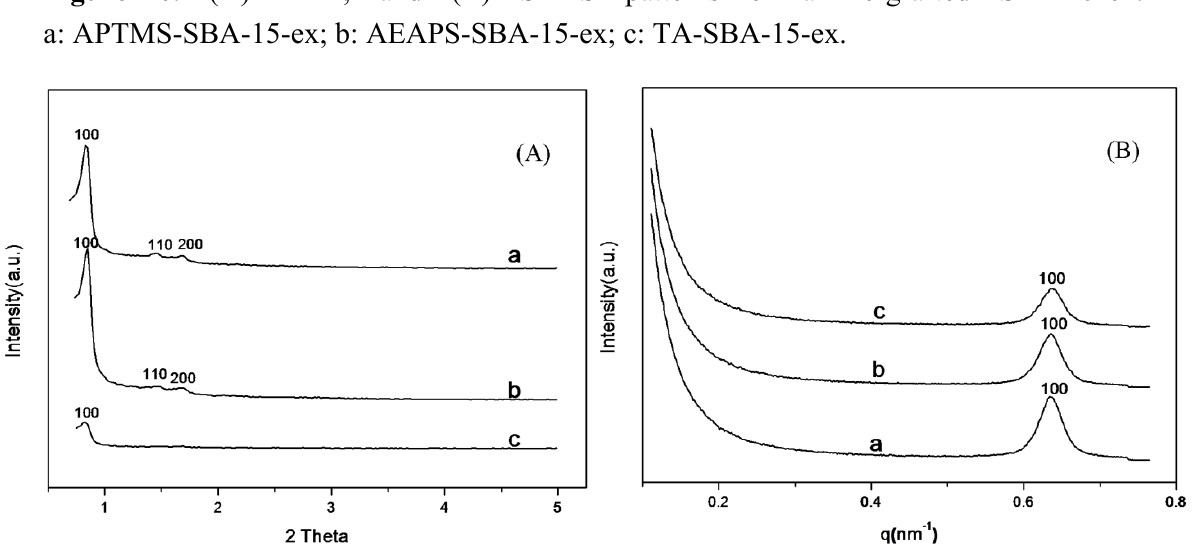
6. ( A ) XRD; and ( B ) SAXS patterns of amine-grafted SBA-15-ex.